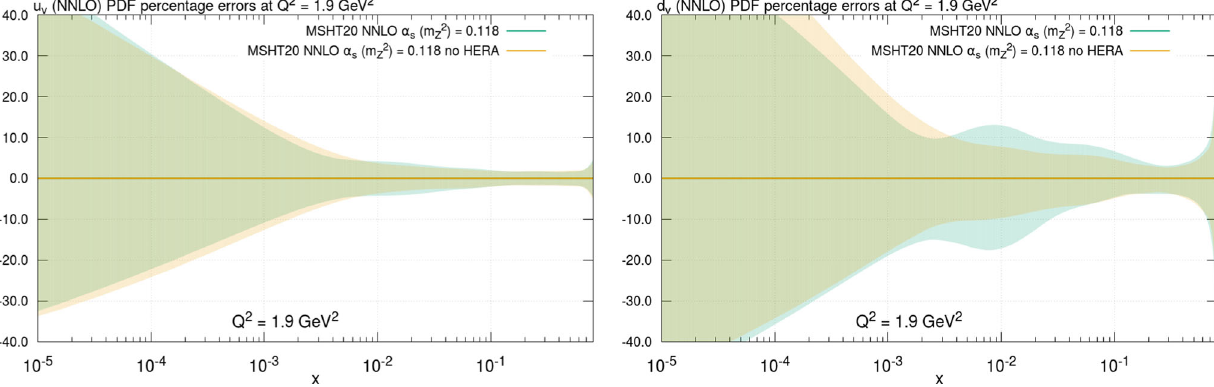
Fig. 76 (Left) u V PDF and (right) d V PDF percentage errors at Q 2 = 1 . 9 GeV 2 at NNLO showing the effect of removing the HERA data from the MSHT20 default global